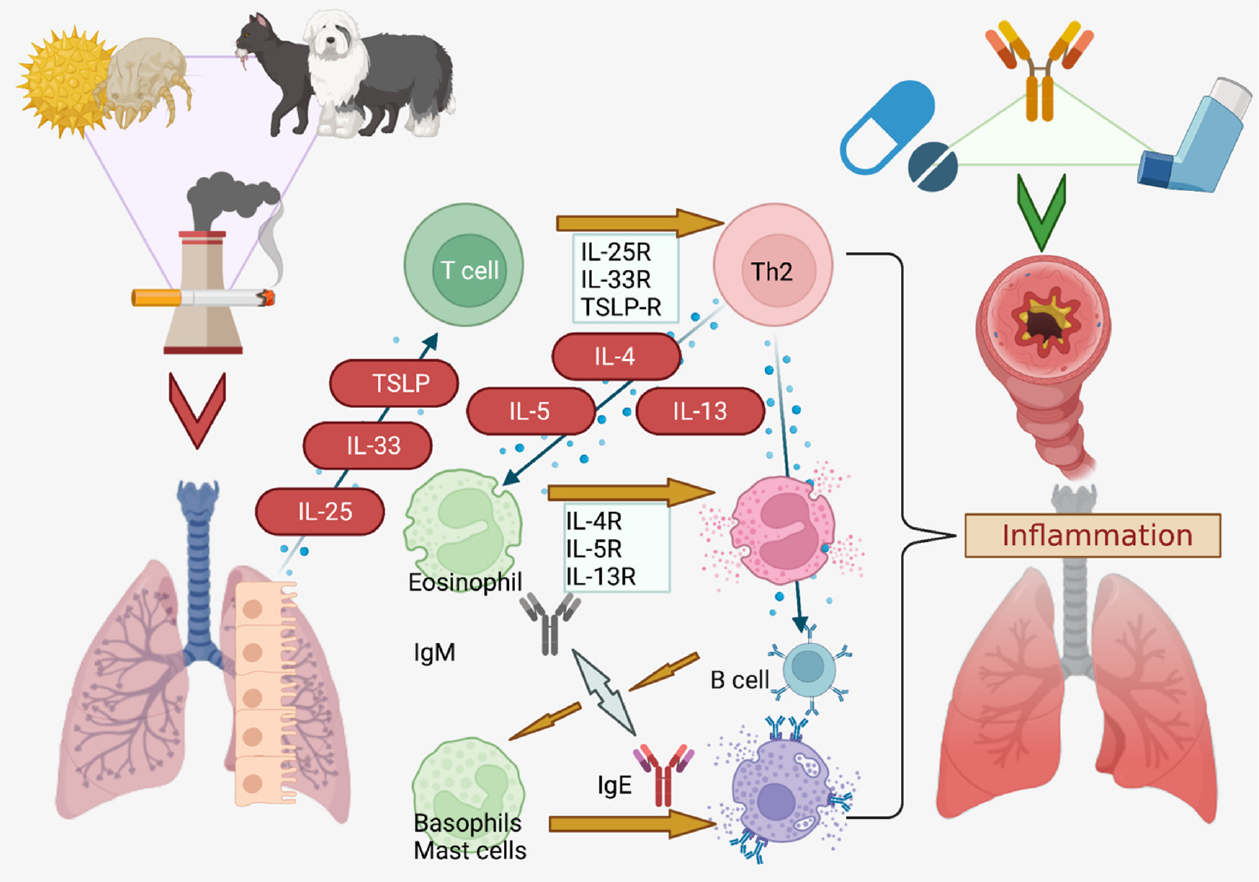
Figure 1. Sources and Pathway of Asthmatic Exacerbations. Dust, pollen, pet dander, and smoke from cigarettes or other sources are potent asthmatic triggers [16,17]. Created in BioRender.com. Briefly, mast cell degranulation, interleukin (IL)-4, IL-5 and IL-13 are downstream mediators of asthmatic exacerbations, while CD4+T helper-2 (Th2) cells play a central role in attracting eosinophils that release IL-5 to upregulate IL-4 and IL-13 [17]. B lymphocytes migrate via CCL and CXCL-motif chemokines (chiefly CCL21 and CXCL12/13) and are signaled by IL-4, IL-13, BLIMP1, and Xbox protein 1 to generate large amounts of IgE that stimulates the IgE receptor (Fc ε R1) on migrated mucosal mast cells, triggering a cascade comprised of cytokines, neutrophils, histamine, leukotrienes (Cys-LT), and prostaglandin D2 (PG-D2) (among others) [18–20]. Additionally, tryptase and chymase are released from mast cells that damage the airway cells with proteolytic action, while the fibrotic